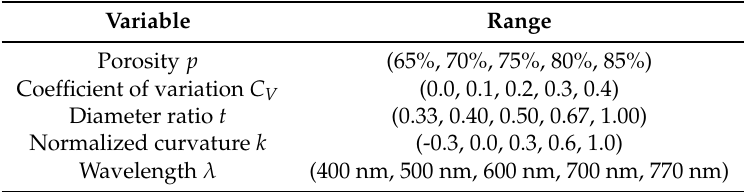
Table 3. The variables and their values which are controlled in subsequent sections.